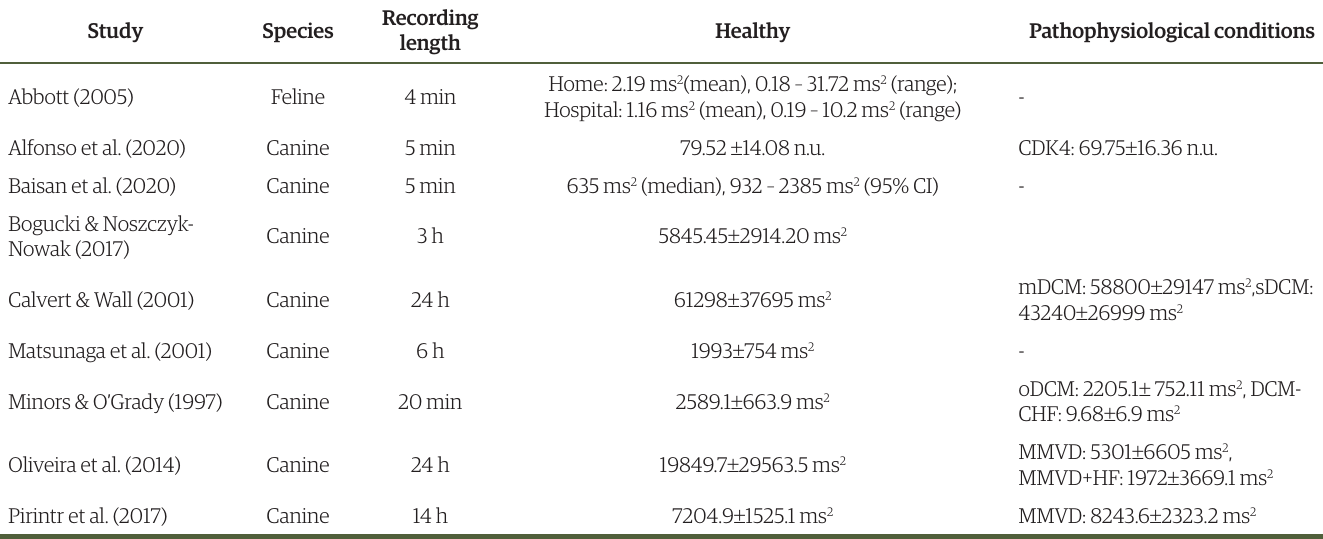
Table 9. Summary results of selected studies from the literature, depicting the recording length for data acquisition and the HF values for healthy animals or those presenting pathophysiological